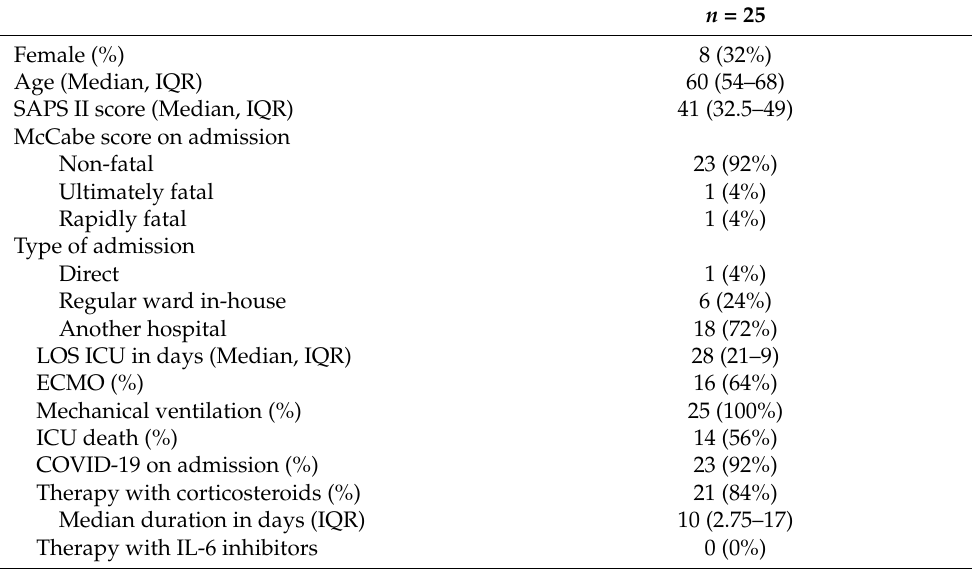
Table 3. Characteristics of COVID-19 patients at ICU with